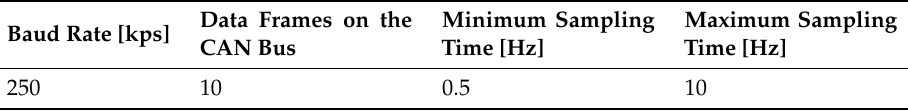
Table 3. CAN bus and data